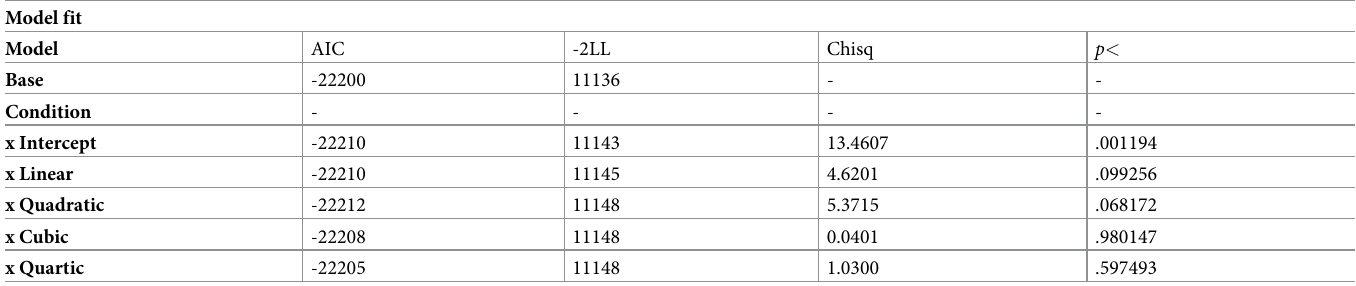
Table 7. Analysis of the goodness of fit of the model in the global post-verbal